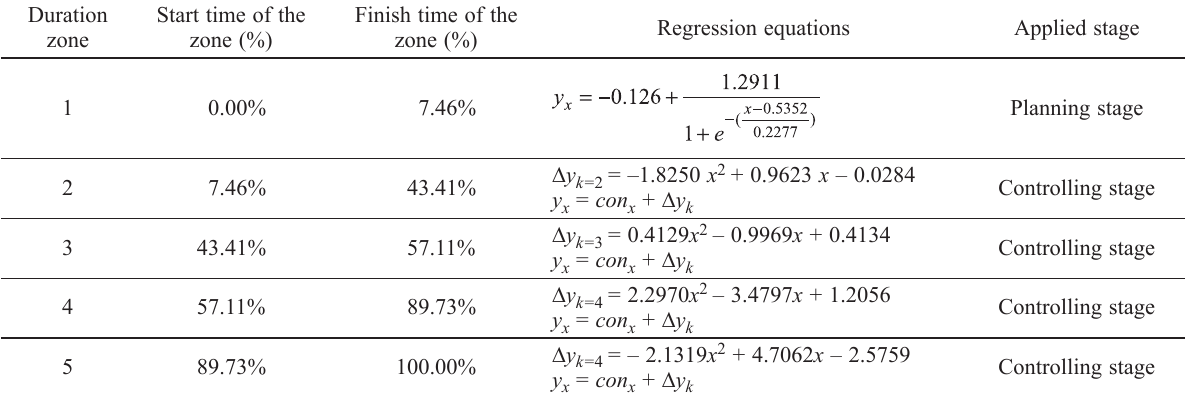
Regression equations Applied stage